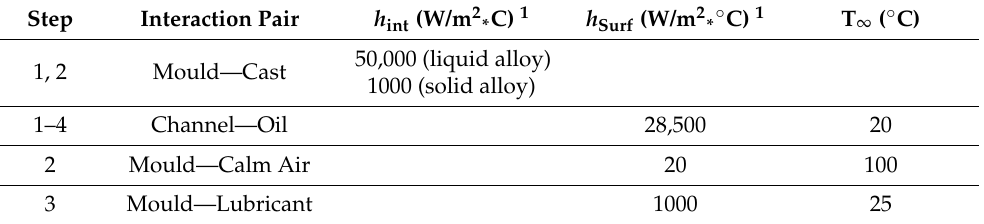
Table 3. Values of heat transfer coefficients h int and h Surf used in the temperature model. Step